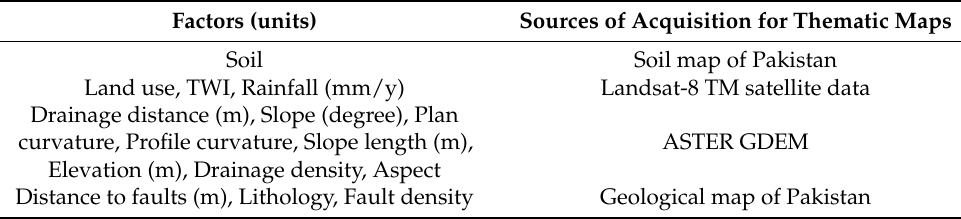
Table 3. Acquisition of Thematic Maps for Contributing